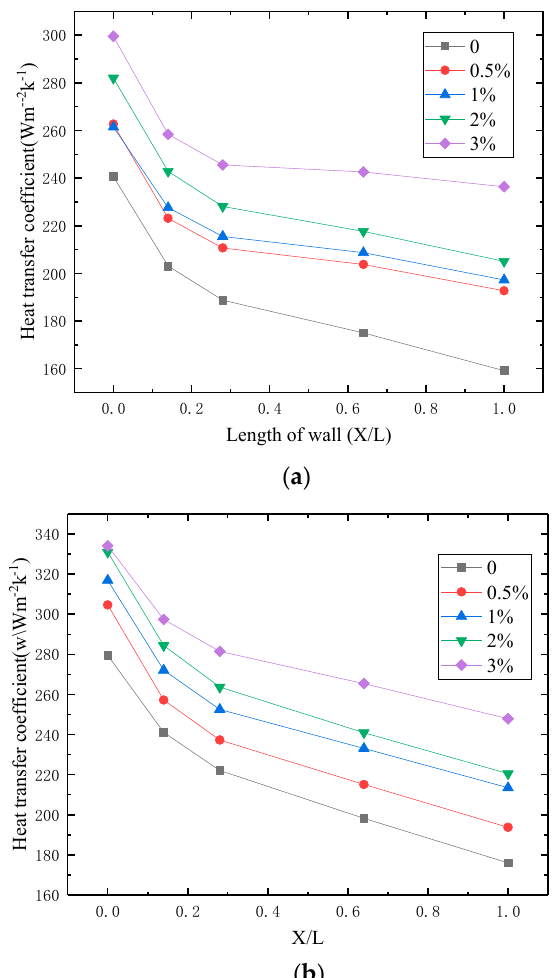
Figure 11. Local heat transfer coefficient for different samples along the tube length at different flow rates: ( a ) flow rate u = 0.35 m/s; ( b ) flow rate u = 0.50 m/s.